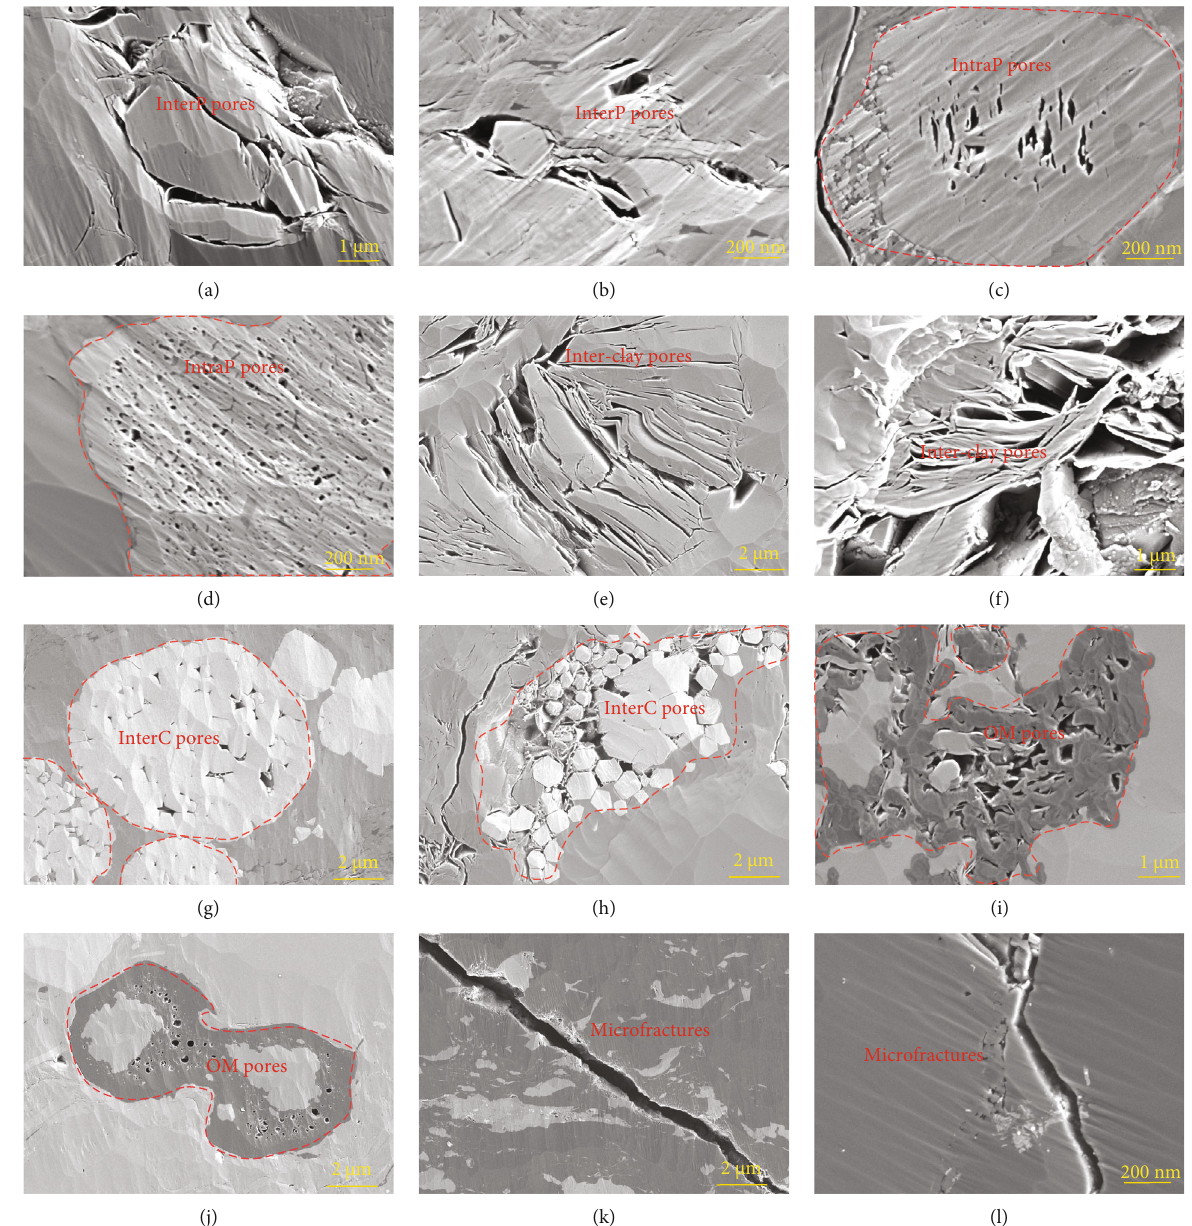
Figure 5: The presence of di ff erent pore types in the Shanxi Formation and Taiyuan Formation. (a, b) InterP pores, 2118.93 m, 2122.22m. (c, d) IntraP pores, 2129.20m, 2120.31m. (e, f) Interclay pores, 2125.10m, 2151.41m. (g, h) InterC pores, 2135.98m, 2145.29 m. (i, j) OM pores, 2143.59m, 2134.16m. (k, l) Microfractures, 3136.56m, 2137.66